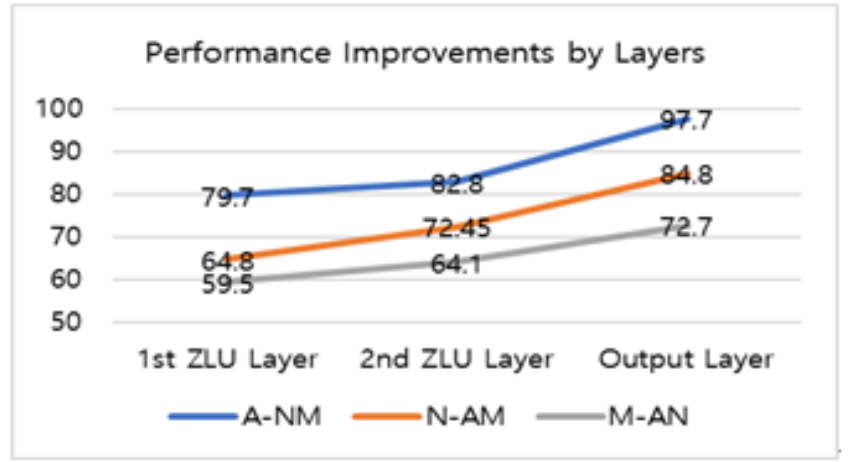
Figure 5. Performance improvements by stacking layers of the ZNN for three AD assessments (%).